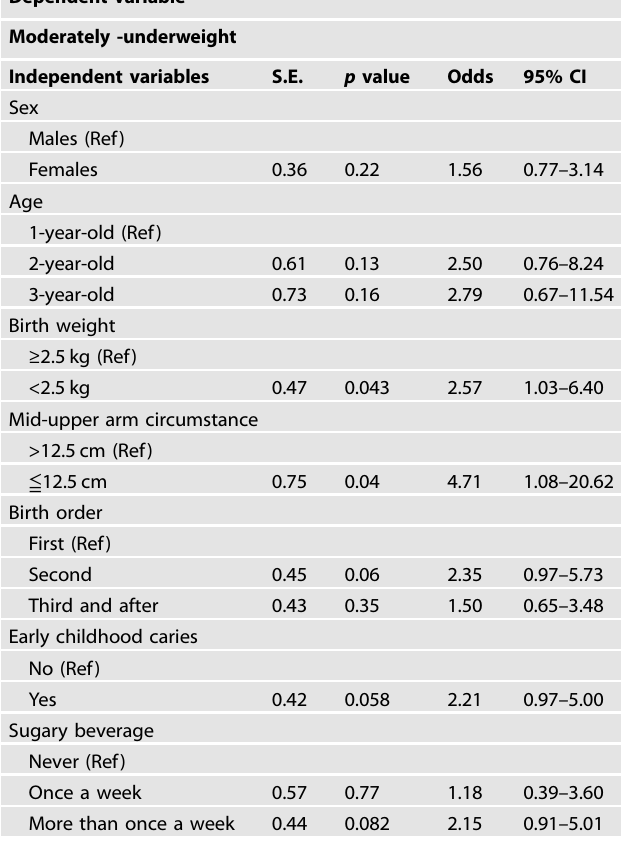
Table 2. Logistic regression analysis on moderately -underweight among young children ( n = 200).